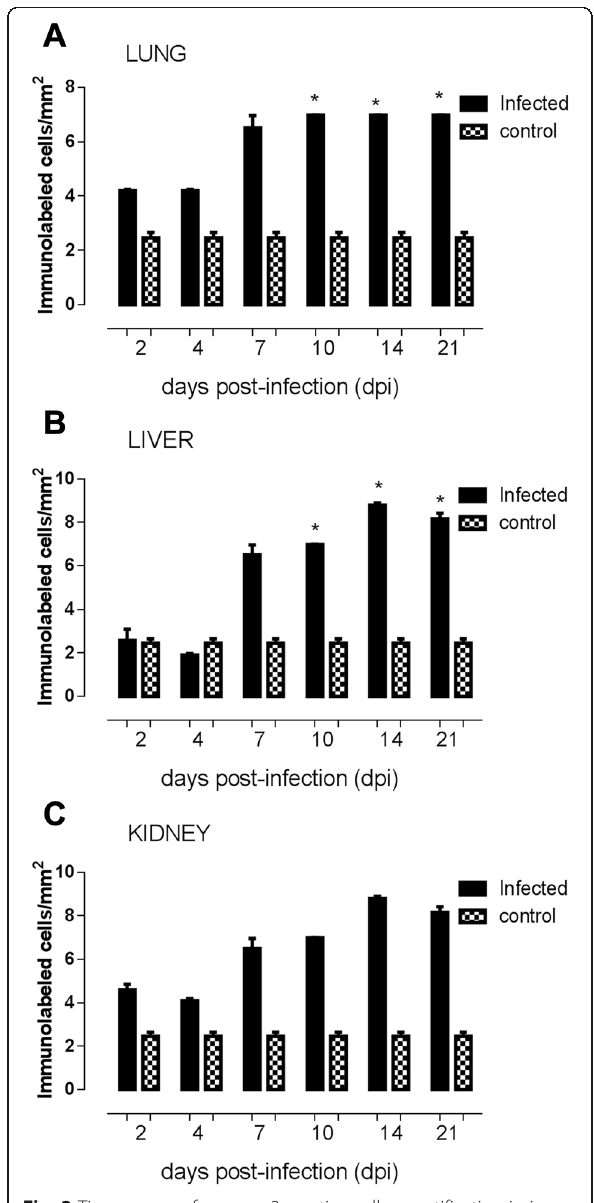
Fig. 3 Time course of caspase-3 reactive cells quantification in in BALB/c lung, liver and kidney tissue. a Lung sections at 7, 10 and 14 dpi presented the highest levels of caspase-3 positive cells compared to initial dpi. b Number of caspase-3 reactive cells in liver sections mostly detected at 14 and 21 dpi. c Kidney sections showed superior number of caspase-3 reactive cells at 14 and 21 dpi, both compared to early stages of infection and to control group. Values are means±SD (n=5 animals). * Statistically different, p